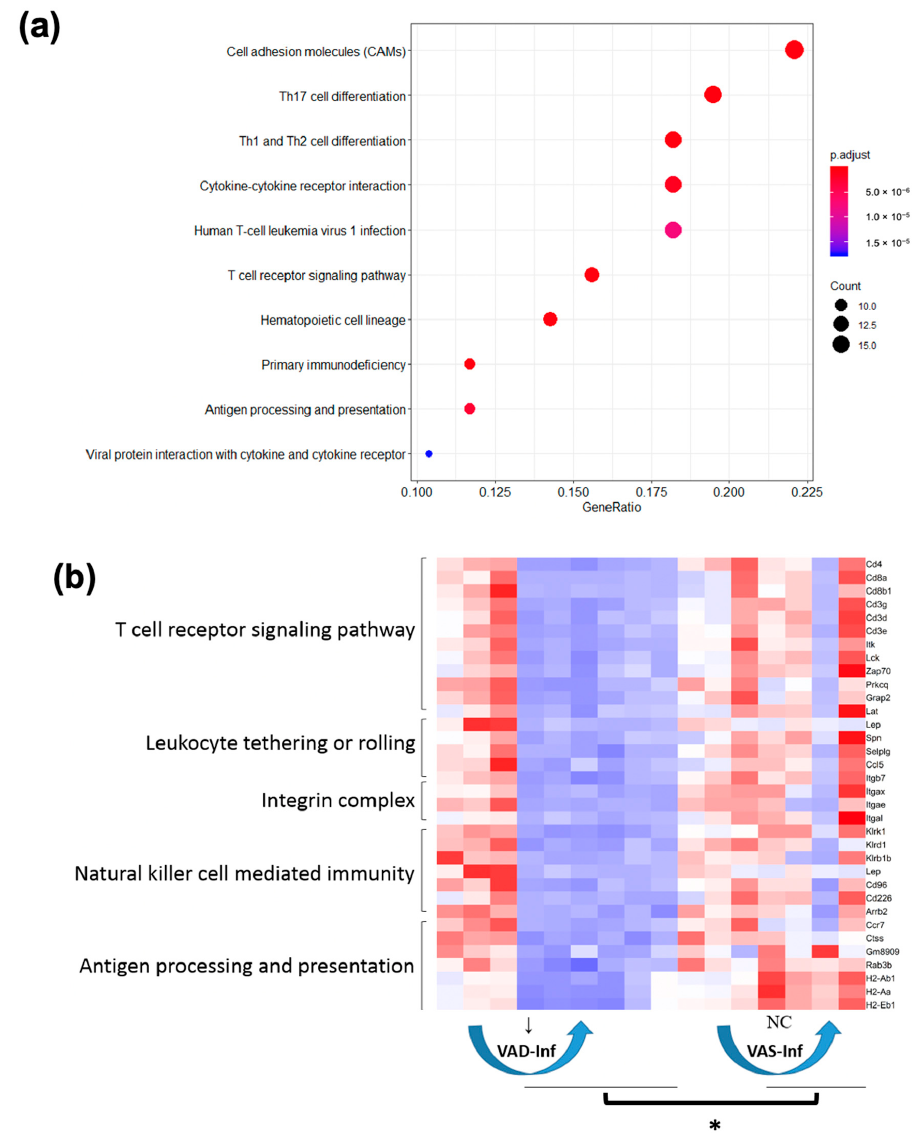
Figure 5. Biological functions altered in Scenario 4 in the colon. ( a ) Top 10 KEGG terms enriched for Scenario 4. Criteria: padj < 0.05. Count: number of the Scenario 4 genes that fell in the corresponding category. GeneRatio: count/(total number of genes in the test). ( b ) Heatmap of the DEGs enriched for representative GO and KEGG terms. Red: higher expression; blue: lower expression. Non ‐ in ‐ fected VAD: columns 1, 2, and 3. Infected VAD: columns 4, 5, 6, 7, 8, and 9. Non ‐ infected VAS: columns 10, 11, and 12. Infected VAS: 13, 14, 15, and 16. ↓ means downregulation. Note: * expression levels of those genes in the VAS infected group were significantly higher than in the VAD infected group (adjusted p ‐ value < 0.05 and |FoldChange| > 2). For a full list of genes corresponding to Sce ‐ nario 4 of the interaction effect see Scenario 4 in the supplementary Excel file. Abbreviations : Kyoto Encyclopedia of Genes and Genomes (KEGG), Gene Ontology (GO), padj (Benjamini and Hochberg ‐ adjusted p ‐ value, hypergeometric test), differentially expressed gene (DEG), no change (NC), vita ‐ min A ‐ sufficient (VAS), vitamin A ‐ deficient (VAD), infection effect under the VAS status (VAS ‐ Inf), infection effect under the VAD status (VAD ‐ Inf).